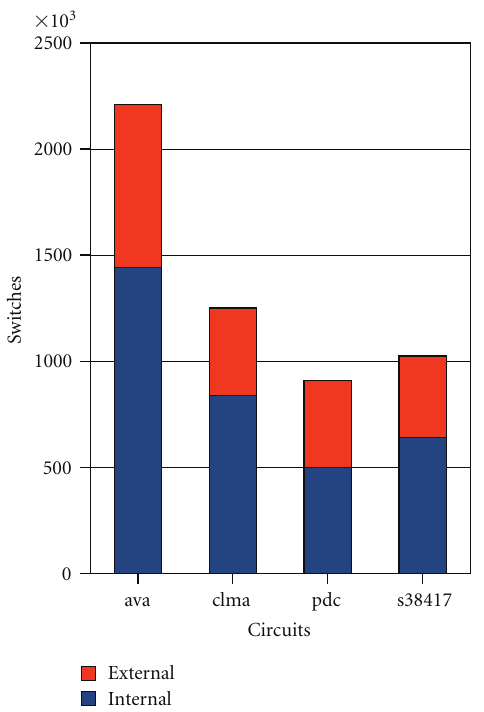
Figure 22: Interconnect distribution in Mesh of Tree architecture.